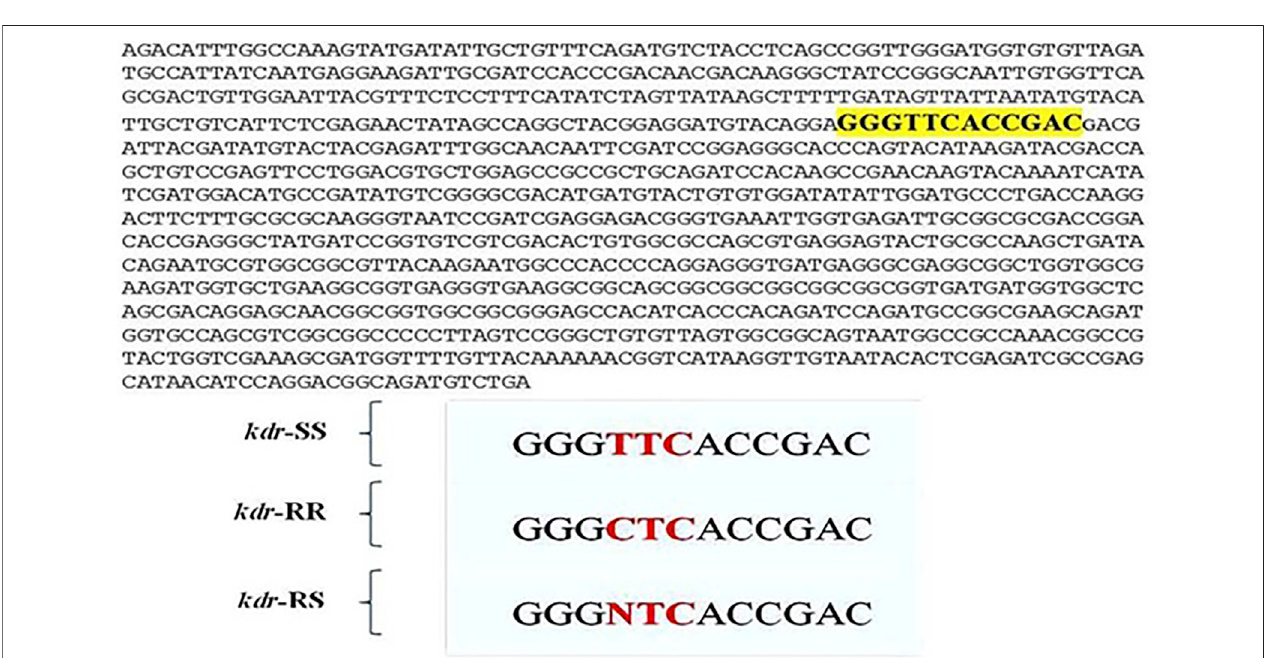
FIGURE 3 | Kdr mutation in house fl y Musca domestica L. population from district Jhang. Lower panel: The mutation was identi fi ed from collected samples of house fl y, Musca domestica L. at position 1014 in domain II of transmembrane six of sodium channels. Three kinds of sequences were obtained viz. kdr homozygous resistant ( kdr -RR), kdr homozygous susceptible ( kdr -SS), and kdr resistant ( kdr -RS).